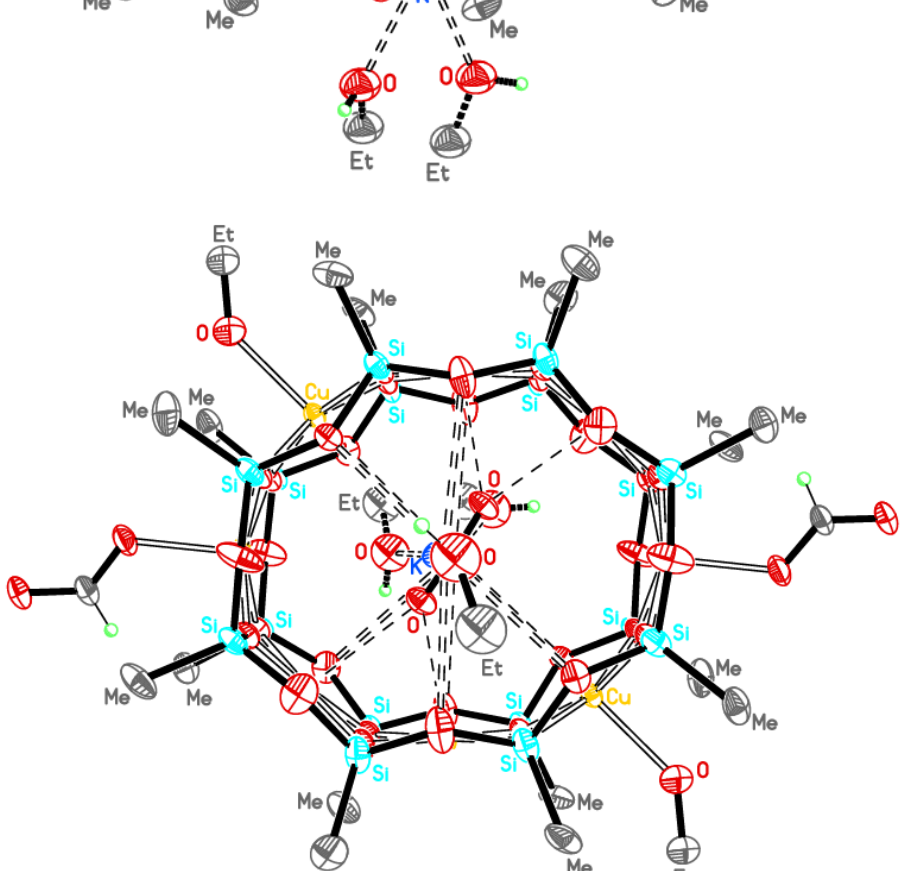
Figure 3. Two projections of molecular structure of complex [(MeSiO 2 ) 8 ] 2 Cu 8 (HCOO) (EtOH) 4 K 2 (MeCOO)] • 2 (EtOH)} n 2 ; the solvate ethanol molecules are not shown.